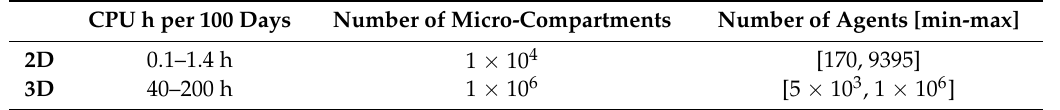
Table 1. Implementation and high performance computing